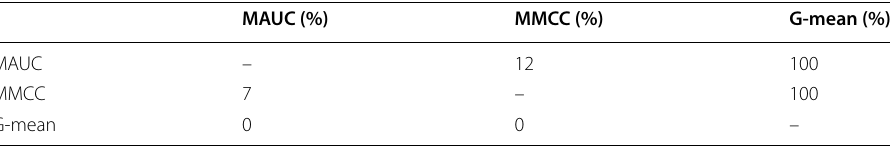
Table 17 Experimental results for verifying degree of discriminancy (D) of evaluation metrics